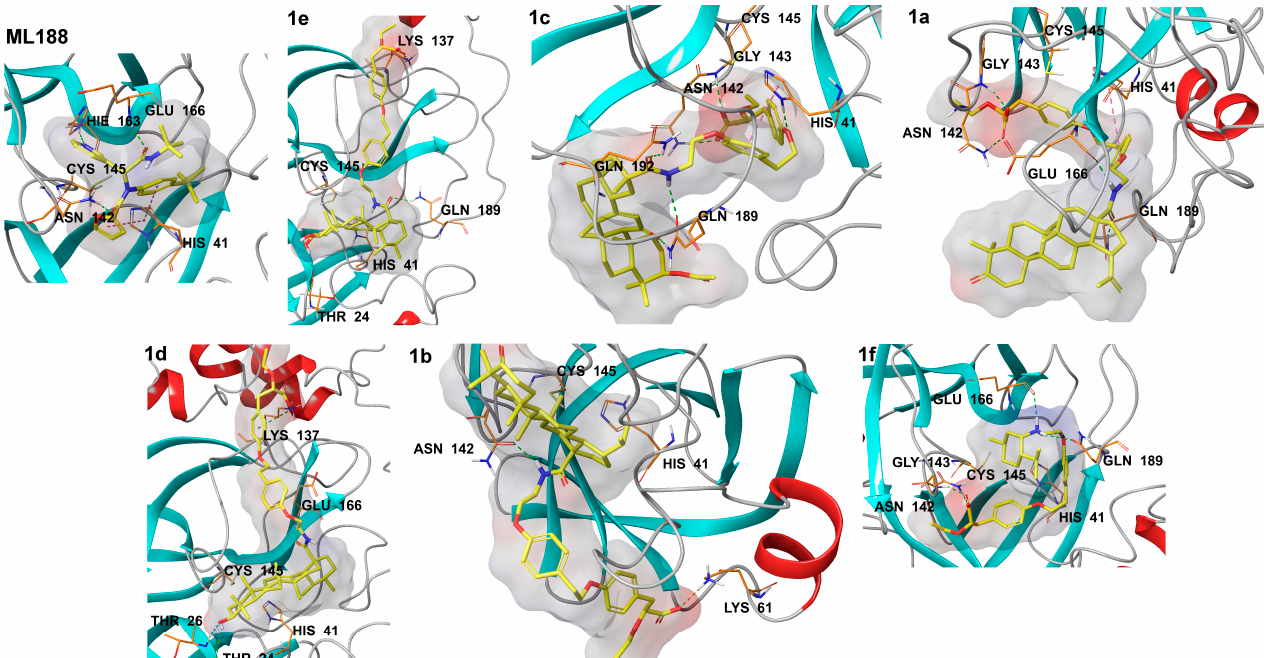
Figure 4. Non-covalent interactions of compounds (1 a – f ) in the active site of the SARS-CoV-2 Mpro compared to the inhibitor ML188 (ML188). Non-covalent interactions are shown by dotted lines: green—hydrogen bonds, orange—ionic interactions, magenta—stacking interactions, dark green—pi-cation interactions.